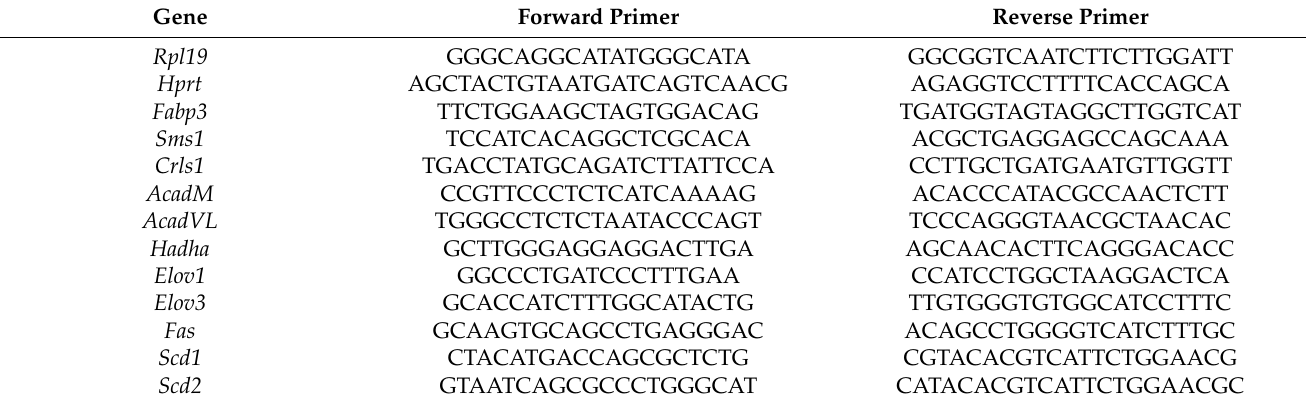
Table 1. Sequence of qPCR